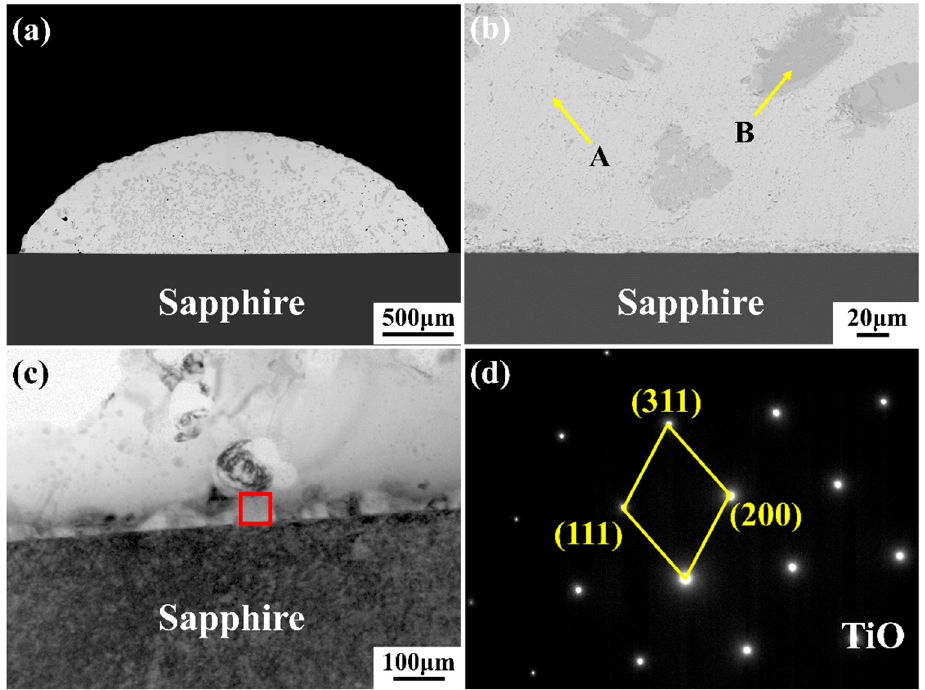
Figure 3. ( a ) Interfacial microstructure of Sn-3Ti/sapphire system; ( b ) high-magnification details of ( a ); ( c ) TEM micrographs of TiO grain from the interface; and ( d ) the SAED patterns corresponding to the zone indicated in ( c